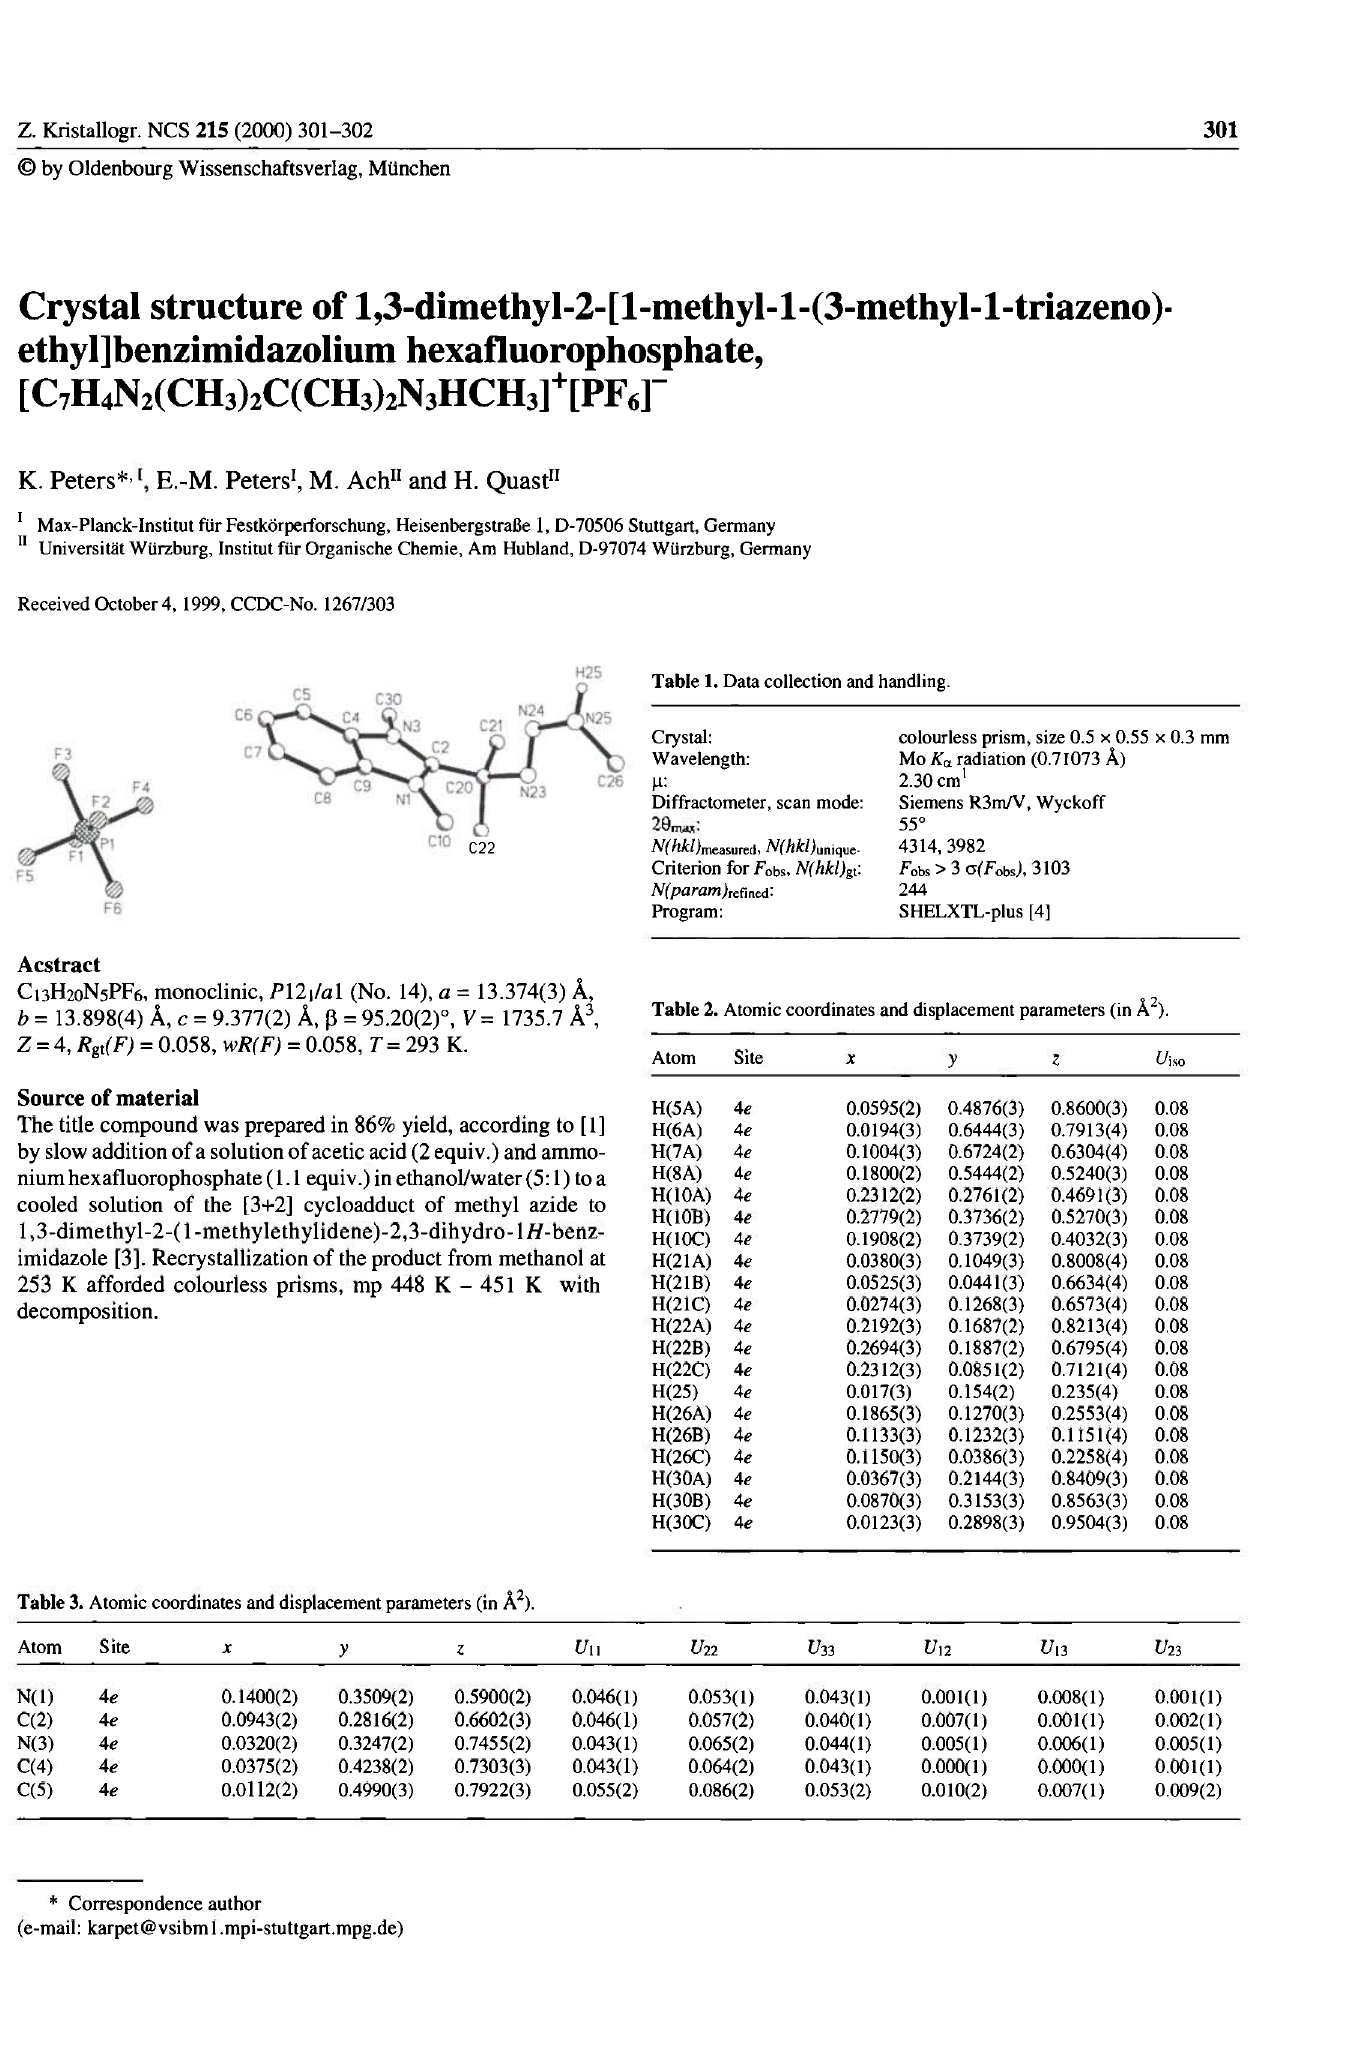
Table 3. Atomic coordinates and displacement parameters (in Ä 2